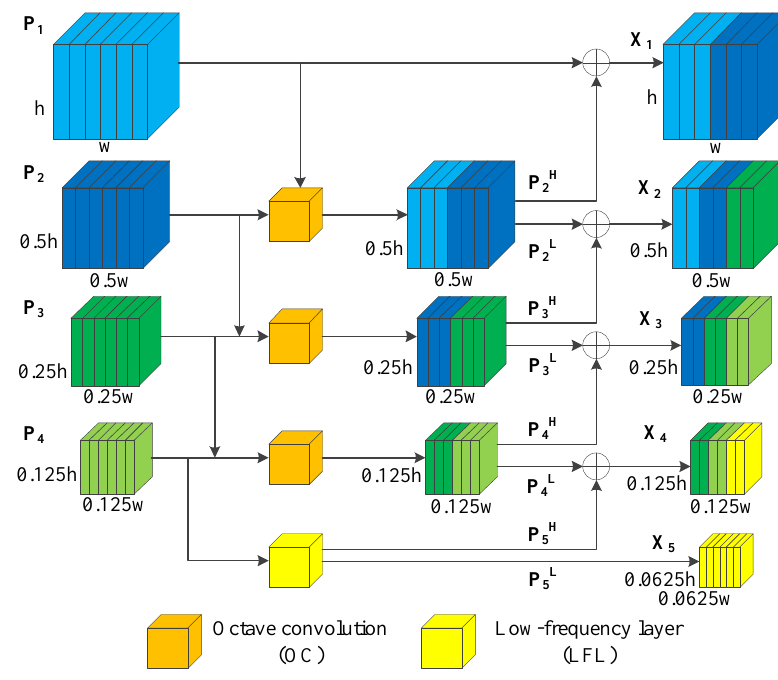
Figure 10. The designed feedback